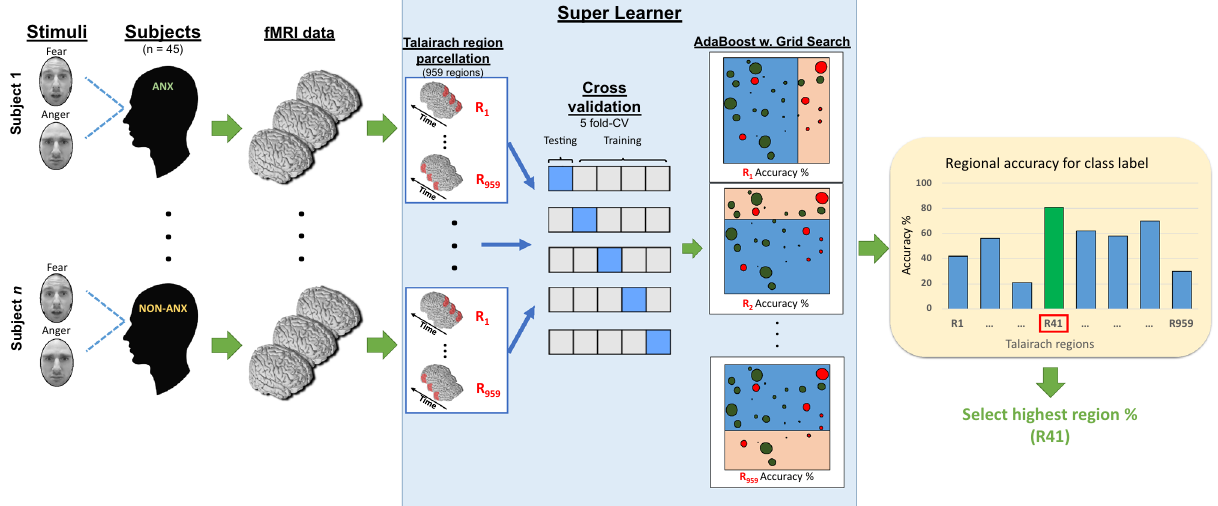
Figure 1. Processing pipeline for selecting the best Talairach region. Super learner (SL) parcellates the whole- brain data into 959 regions based on the Talairach atlas. It determines which region can best distinguish between anxious and non-anxious children. The SL uses a nested cross-validation process to hyper-tune parameters for an AdaBoost model. The SL uses the regions as a hyperparameter within this process. The region with the highest average accuracy was selected for our analysis. Note: each time point produced its own prediction; we labeled each person with the majority vote over the time points for that